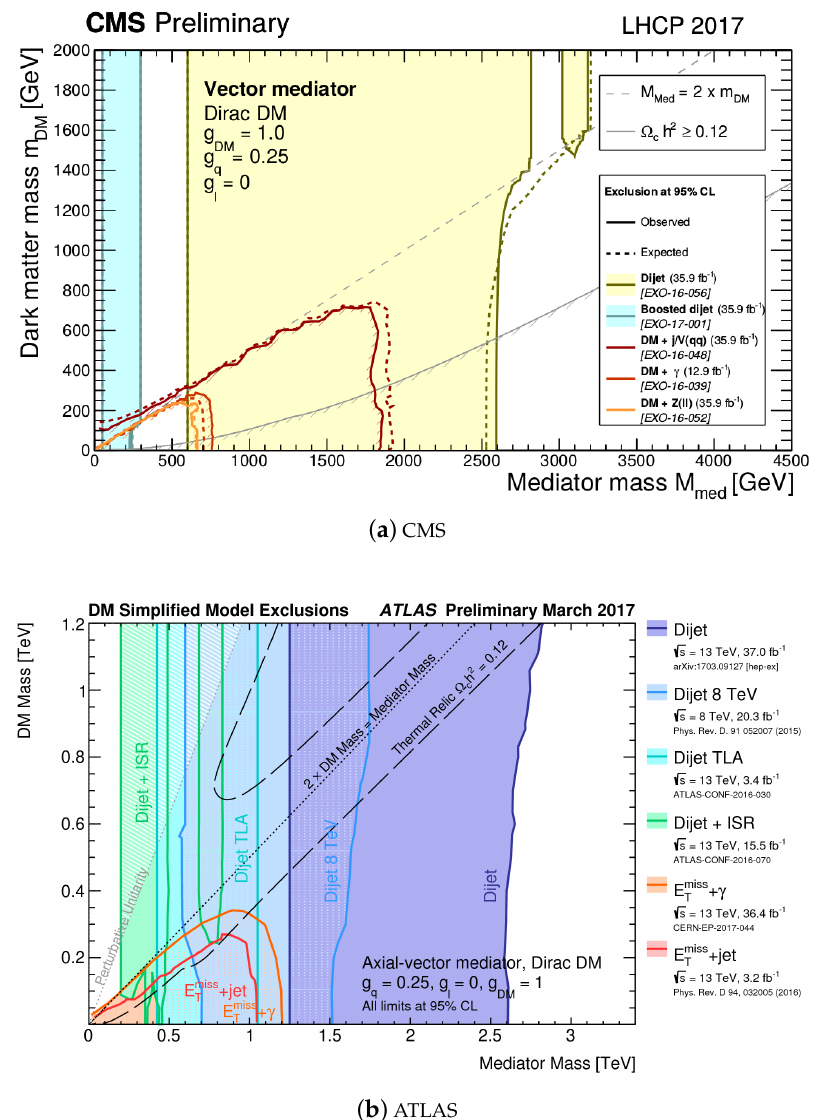
Figure 14. Summary plots for the CMS [27] ( a ) and ATLAS [28] ( b ) dark matter searches. The coupling of the mediator to DM (g DM ) is set to one, to quarks (g q ) to 0.25, and to leptons (g (cid:96) ) to zero. The CMS results refer to the vector-mediator interpretation and the the ATLAS results to the axial-vector